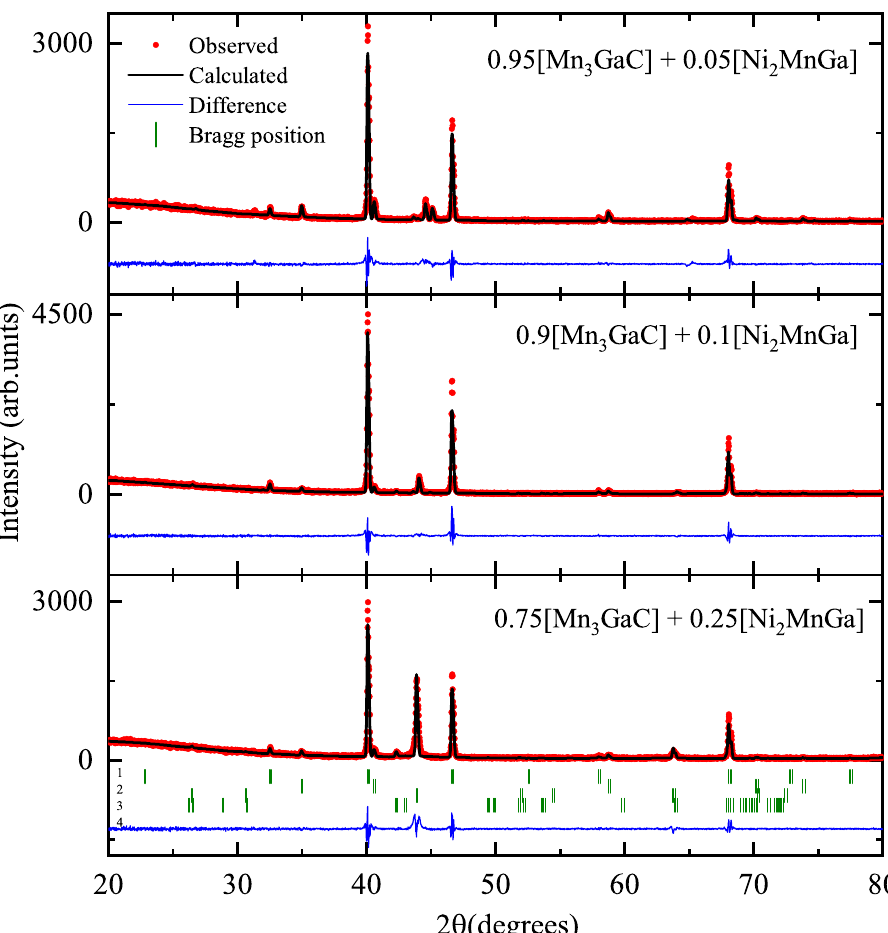
Figure 1. Rietveld refined X-ray diffraction patterns of Mn 3 GaC and Ni 2 MnGa composites. The four identified phases are 1. Mn 3 GaC, 2. MnO, 3. Ni 2 MnGa cubic and 4. Ni 2 MnGa